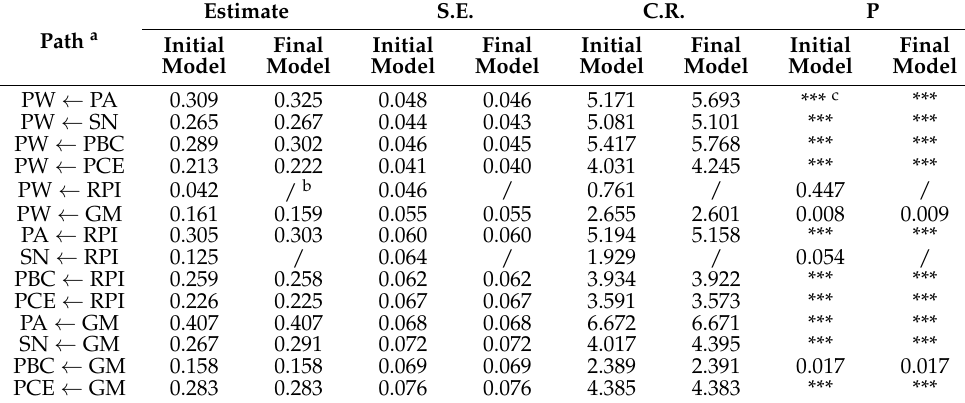
Table 6. Regression weights in the